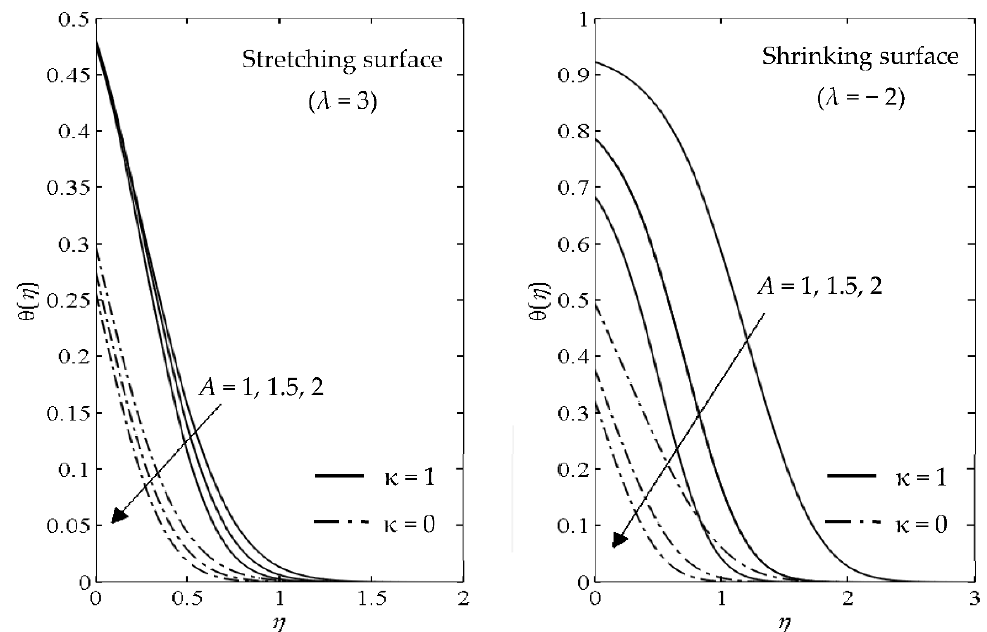
Figure 12. Effect of the velocity ratio parameter, A , on the velocity profiles for different parameters κ and λ .